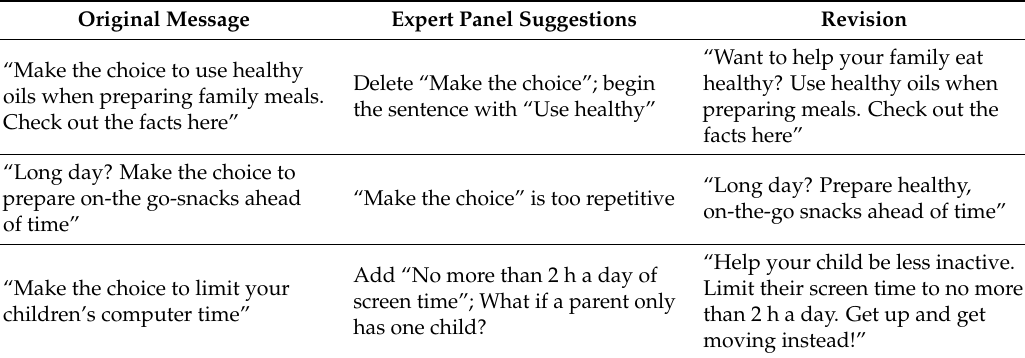
Table 5. Sample messages after expert panel